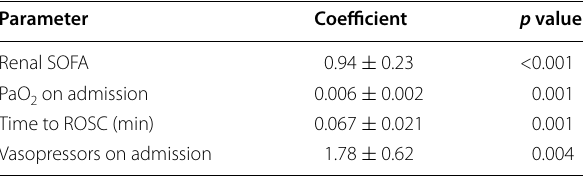
SOFA sequential organ failure assessment, ROSC return of spontaneous circulation